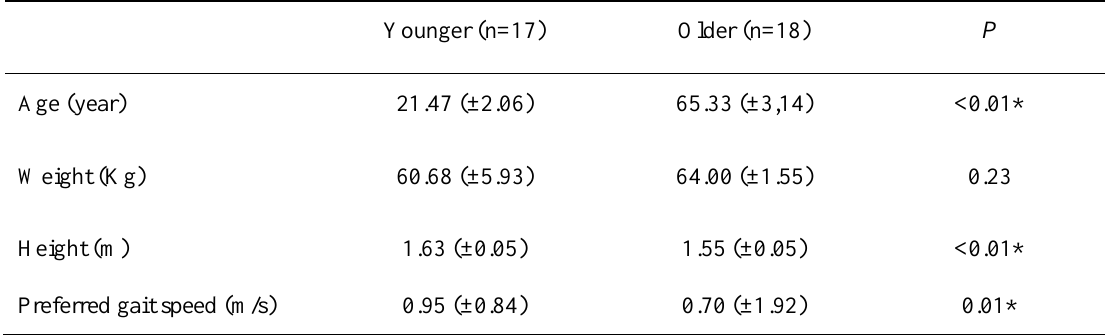
Table 1. Characteristics of the sample (n = 35 women).